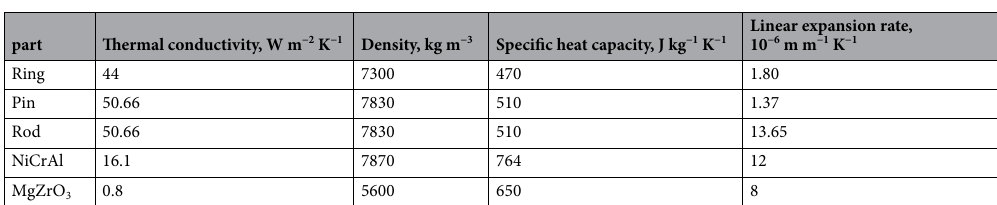
Table 5. Thermophysical parameters of the piston ring, pin, connecting rod, metal bonding layer, and ceramic layer.